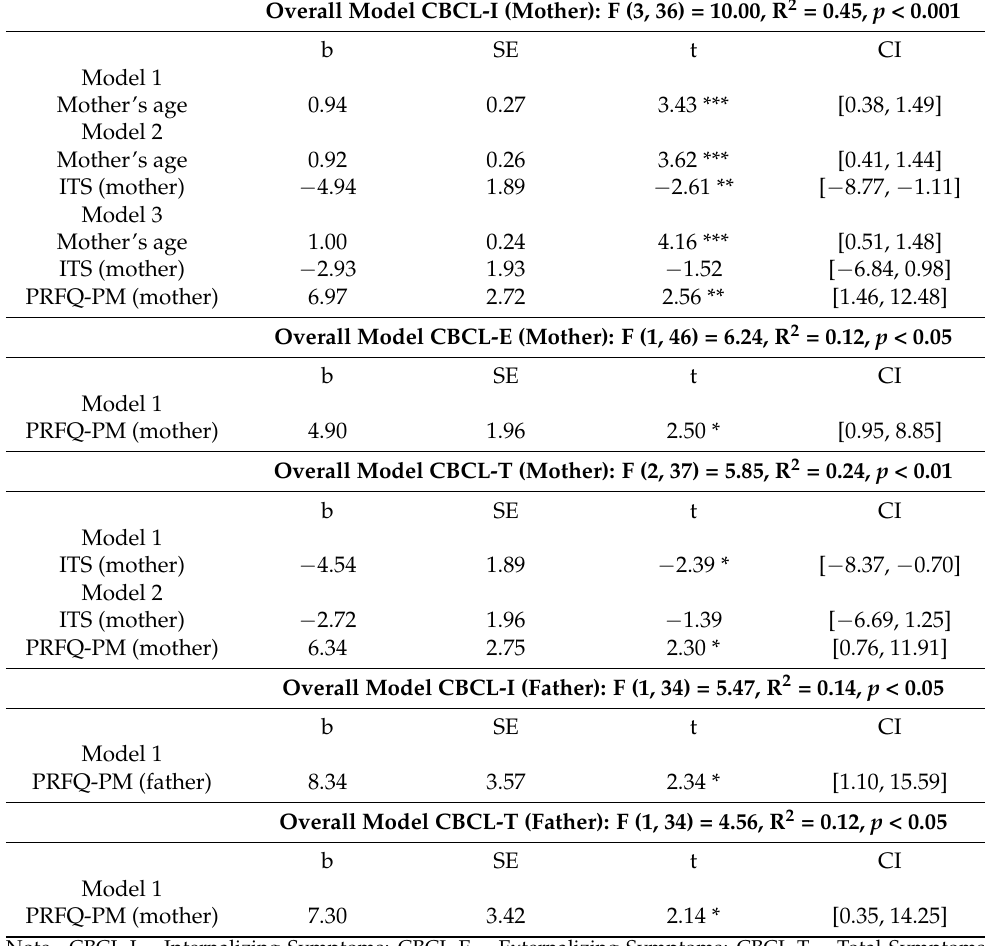
Table 4. Hierarchical multiple regression models predicting child’s psychological